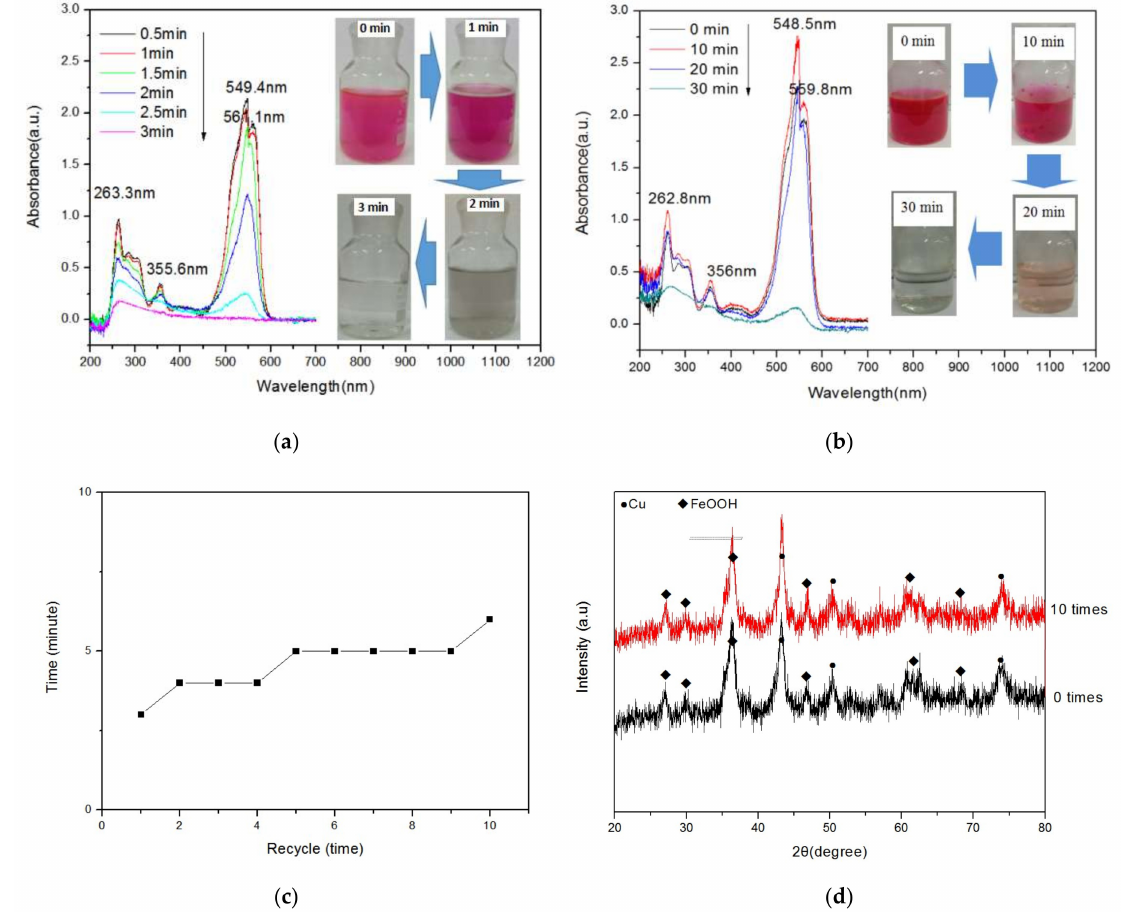
Figure 3. ( a ) UV–vis diffuse reflection spectra of Rhodamine B solution degraded in a microwave field for different durations and corresponding color change. ( b ) UV–vis diffuse reflection spectra of Rhodamine B solution degraded in hot water for different durations and corresponding color changes. ( c ) The time required for degrading Rhodamine B completely with recycling times. ( d ) XRD patterns of original FeOOH/Cu that were reused 10